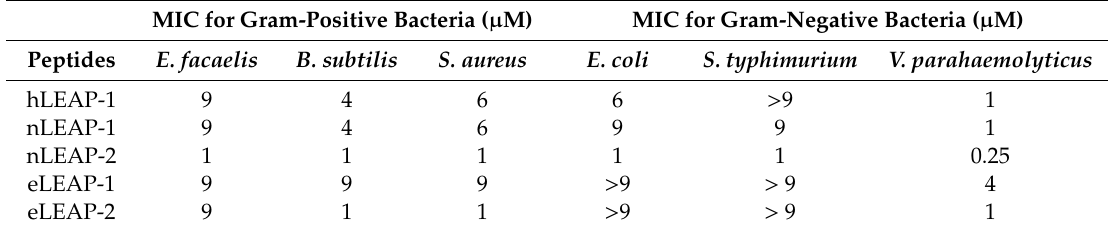
Table 2. Antimicrobial activity of peptides: hLEAP-1 (human), nLEAP-1, nLEAP-2 ( D. mawsoni ), and eLEAP-1, eLEAP-2 ( Lys. dearborni ) against gram-negative and gram-positive bacterial strains. nLEAP-2 e ff ectively inhibited the growth of all bacterial strains with minimum MIC value range of 0.25 to 1 µ M concentration. nLEAP-2 inhibited the growth of B. subtilis , S. aureus and V. parahaemolyticus with MIC (Minimum inhibitory concentration) value of 1 µ M concentration.